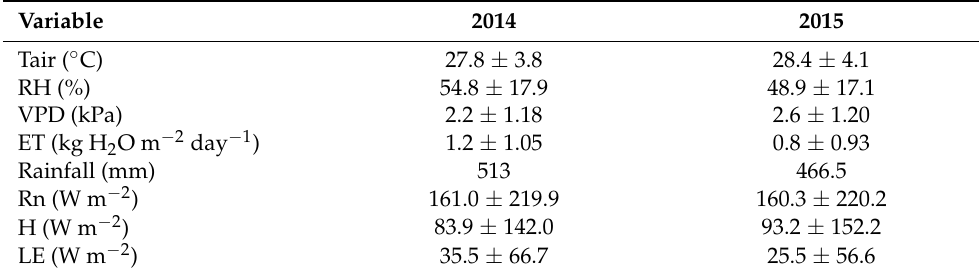
Figure 2. Interannual variability of the monthly: ( a ) accumulated evapotranspiration (ET) and vapor pressure deficit (VPD) average; ( b ) air temperature (Tair) and relative humidity (RH) averages. The monthly accumulated rainfall (yy/mm/dd) is presented in both panels as grey bars. Table 1. Annual average and standard deviation of climate and energy flux variables measured during 2014 and 2015. Rainfall refers to accumulated values.